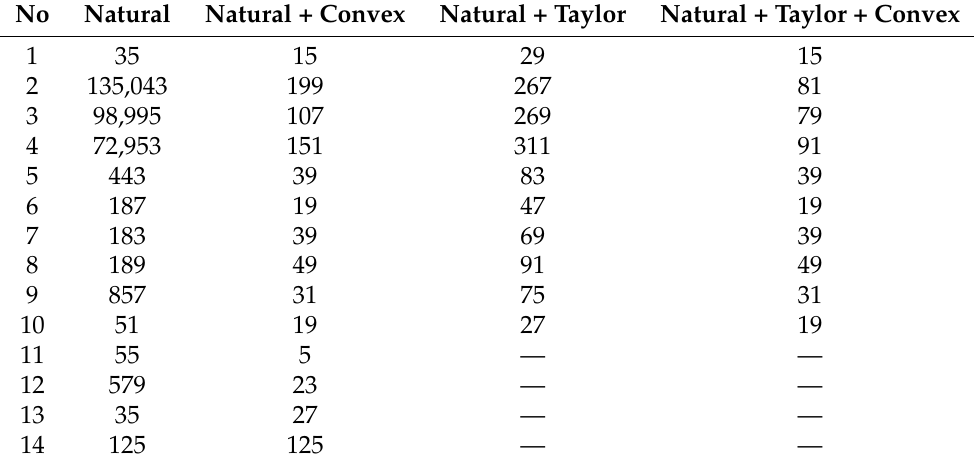
Table 6. Testing